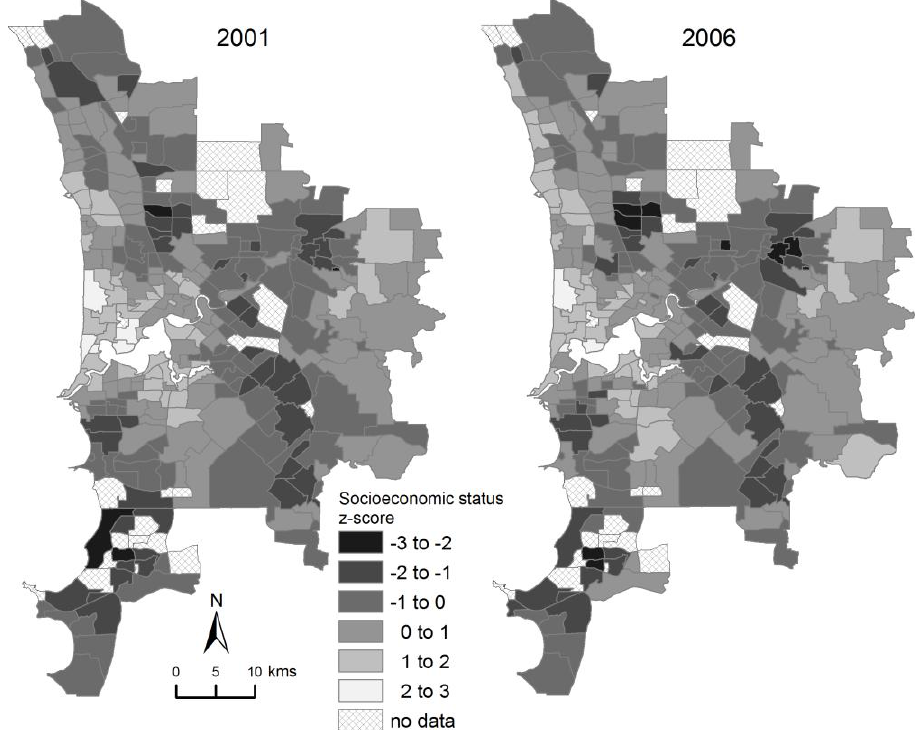
Figure 3. Socioeconomic variation in Perth, mapped as standard deviations from the mean Advantage-Disadvantage Index in each of 2001 and